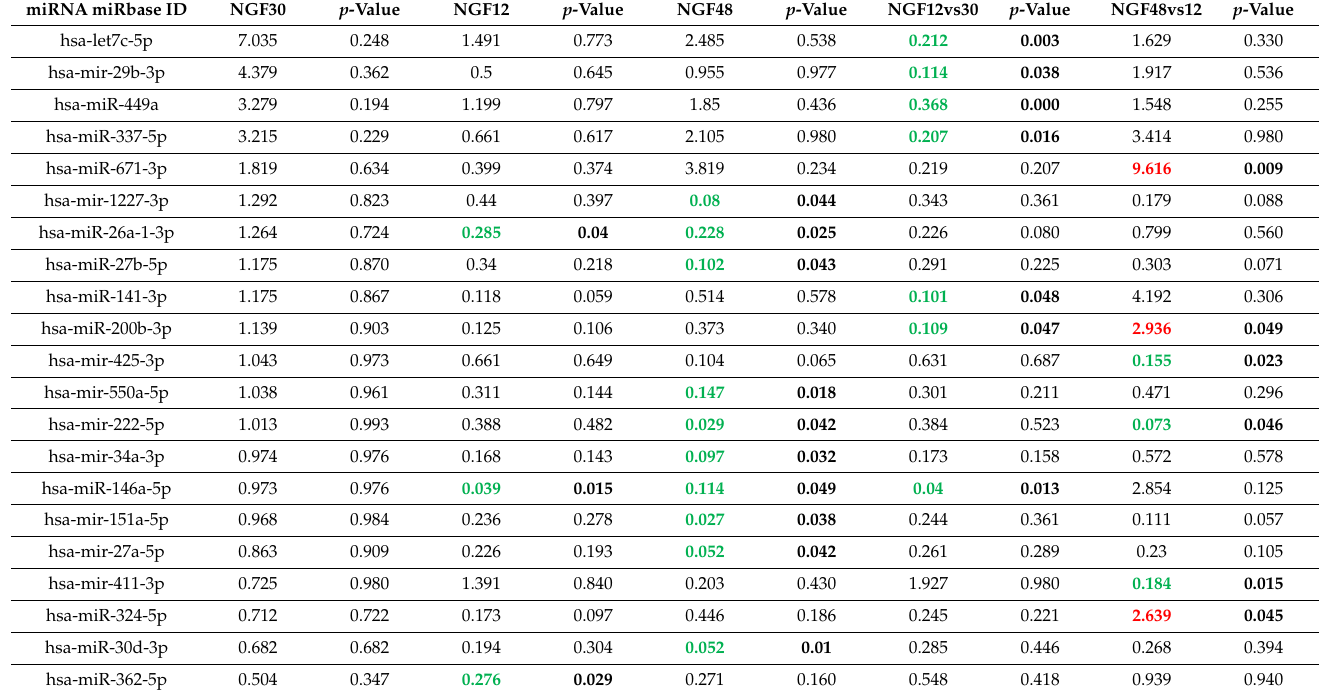
Table 1. Dynamic expression of miRNAs significantly dysregulated (n = 21) at least in 1 comparison, after rhNGF treatment. Relative quantification (RQ) data obtained by comparing 30 min and 12 and 48 h NGF-treated vs. untreated cells (NGF30, NGF12, NGF48), NGF 12 h vs. 30 min (NGF12vs30) and NGF 48 vs. 12 h (NGF 48vs12). Green: RQ values expressing significant downregulation, red: RQ values expressing significant upregulation. Significant p -values in